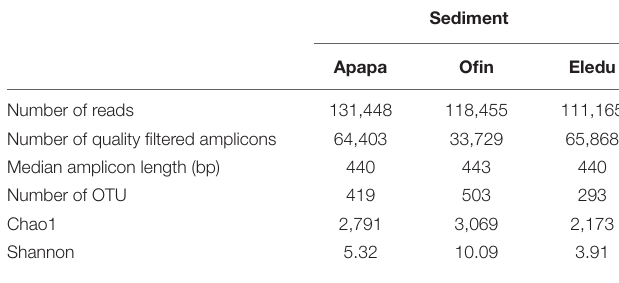
TABLE 2 | Characteristics of Illumina libraries and alpha diversity metrics of sediment